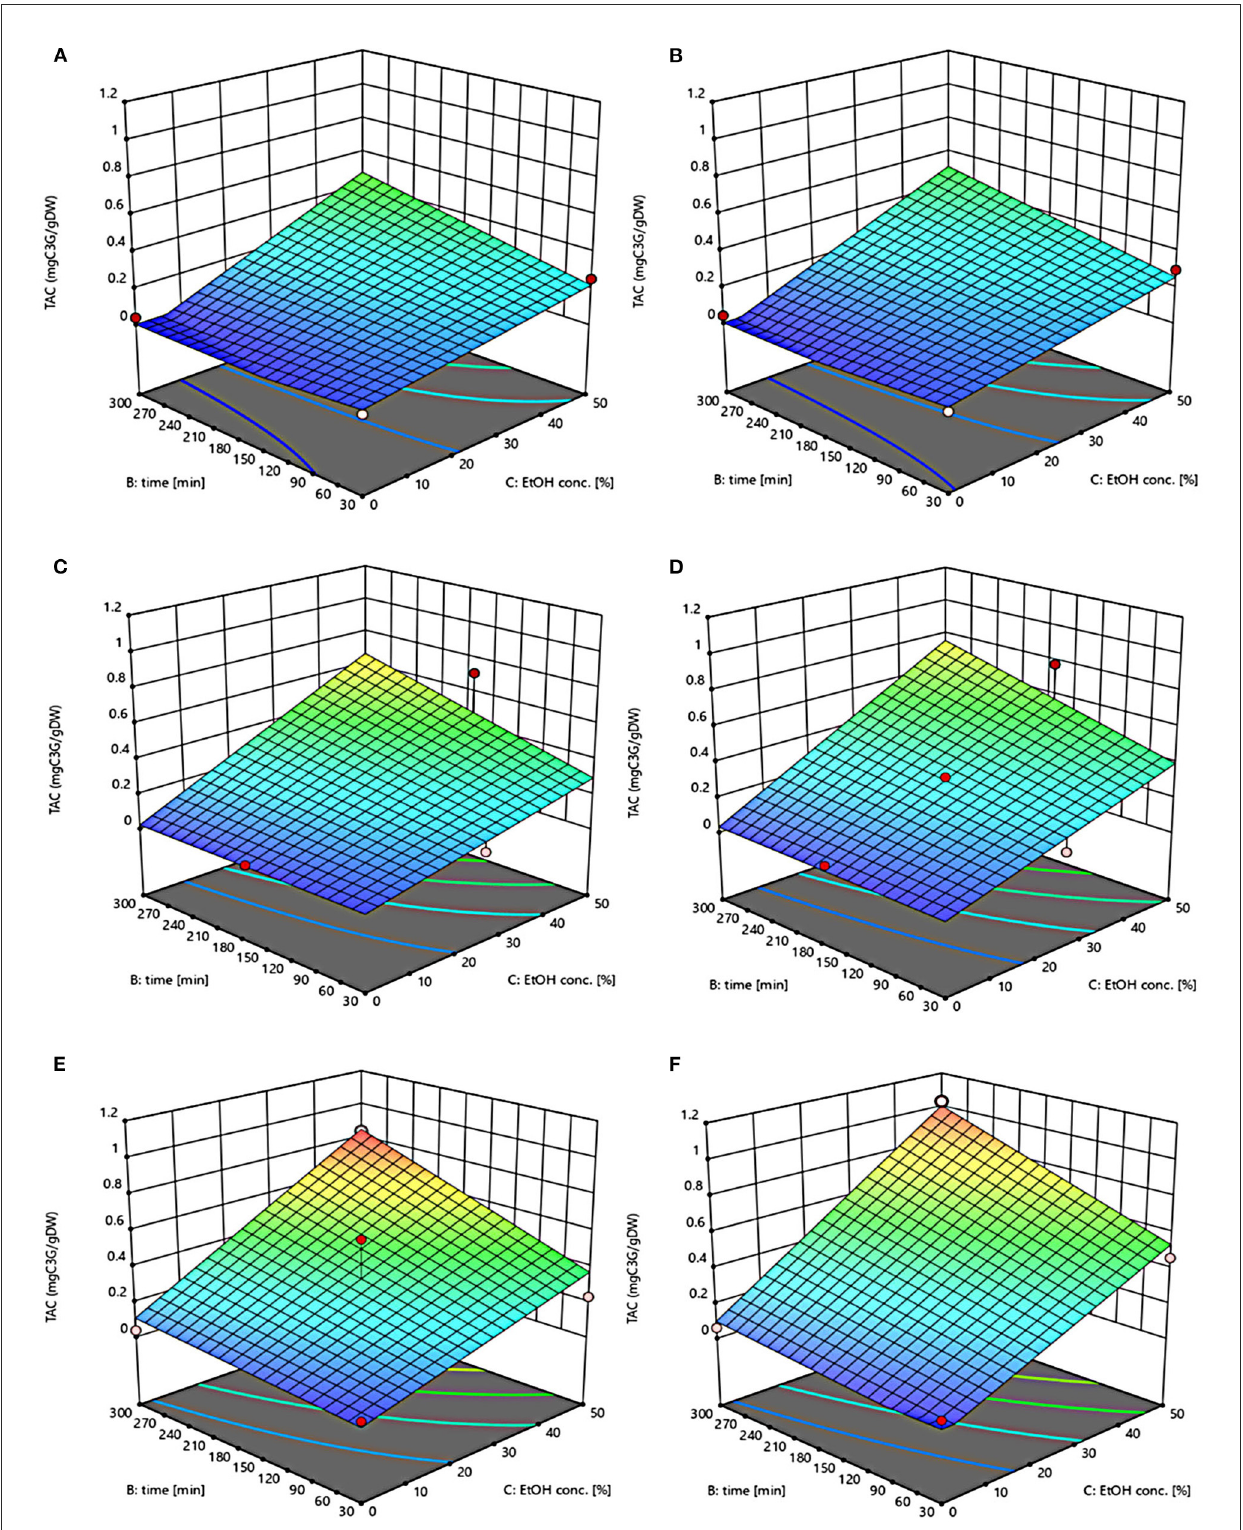
FIGURE4 Response surfaces of Total Anthocyanin Content (TAC) of extracts from untreated (Control) (A, C, E) and PEF-treated (E = 4.6 kV/cm; WT = 20kJ/kg) (B, D, F) grape pomace as a function of extraction time and ethanol concentration. Extraction temperature set at 20 ◦ C (A, B) , 35 ◦ C (C, D) , 50 ◦ C (E, F) .